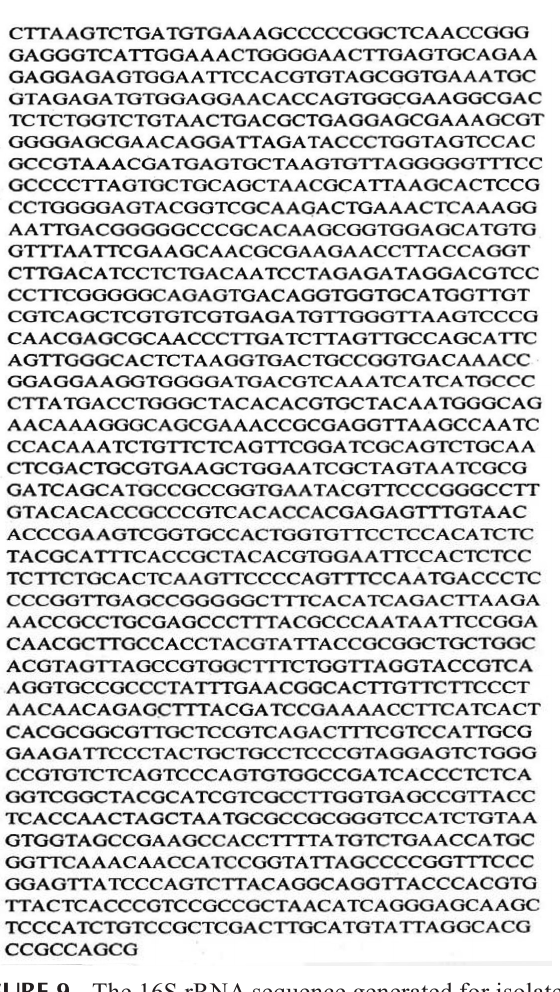
FIGURE 9 - The 16S rRNA sequence generated for isolate-5 had 1550 bases.